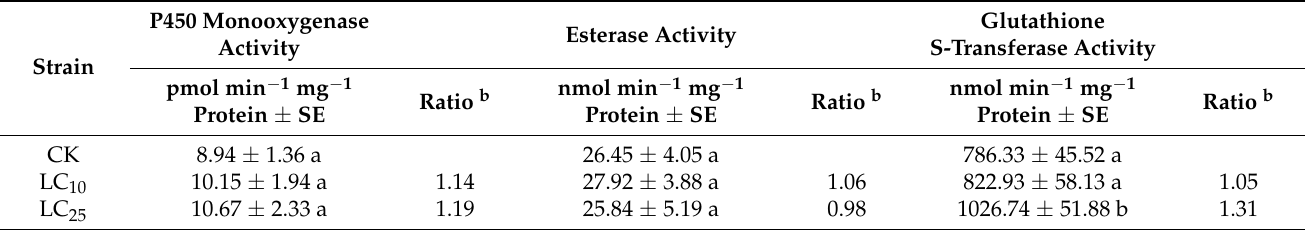
Table 2. Activities of three metabolic enzyme in treatments of LC 10 and LC 25 , and the CK a